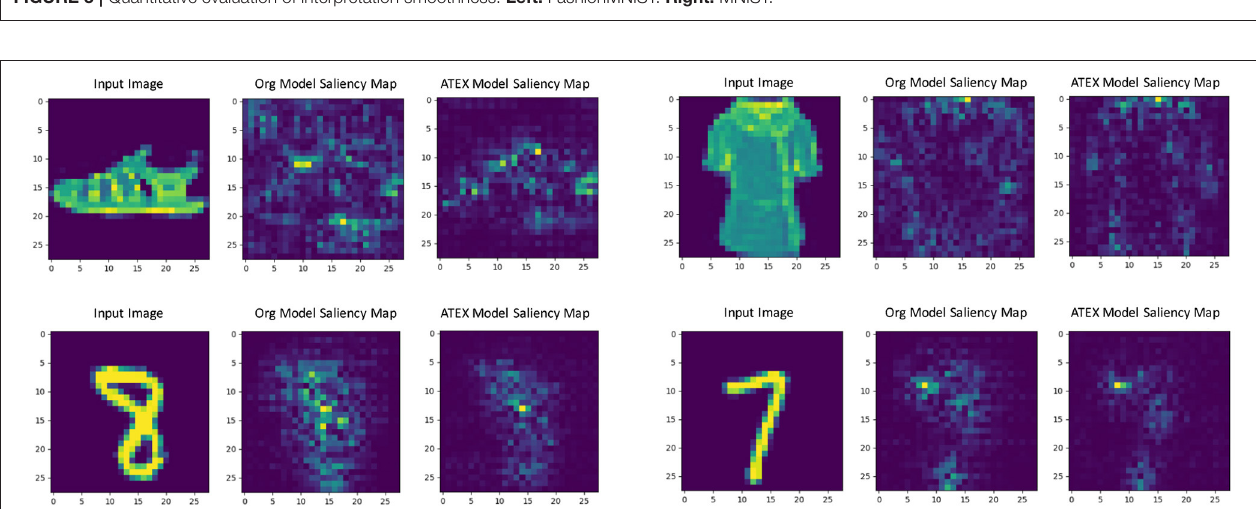
FIGURE 4 | Gradient explanation map produced from the original network and the network trained with ATEX. Three images form a case, which consists of an input, a gradient explanation from the original network, and a gradient explanation from ATEX-trained network.